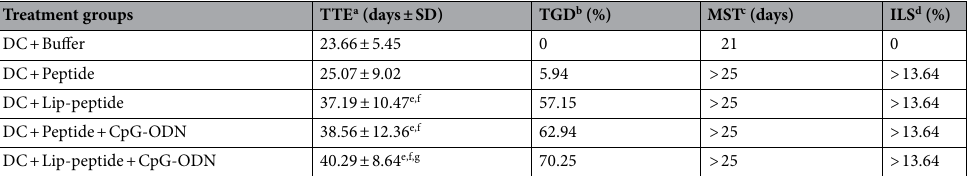
Table 2. Therapeutic efficacy data of different DC-based vaccine formulations in B16F10 tumor mice model. Data are shown as mean ± standard deviation (N = 7). a Time to reach the endpoint. b Tumor growth delay. c Median survival time. d Increased life span. e,f Indicates a significant difference compared with DC + Buffer and DC + Peptide groups, respectively ( P < 0.01). g Indicates a significant difference compared with the DC + Lip- peptide group ( P <